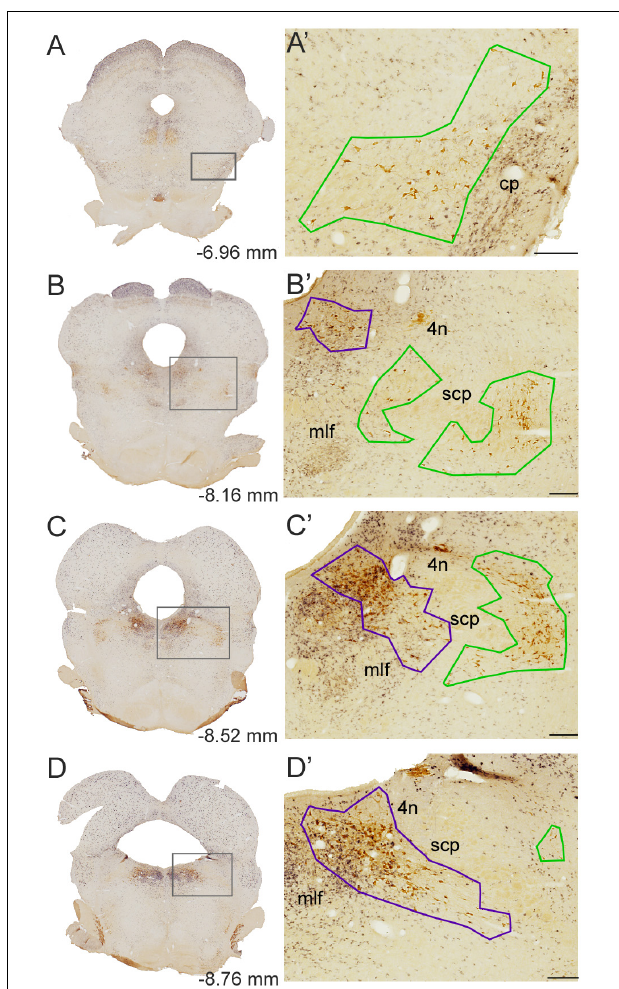
FIGURE 2 | Delineation of the PPN and LDT. (A–D) Representative dually labeled sections in rostrocaudal sequence containing the PPN and LDT. Boxed areas are shown at higher magnification in A’–D’ . (A’–D’) PPN (green) and LDT (purple) contours were drawn at 10 × , prior to quantification. Delineations were carried out linking with straight lines the outermost cholinergic neurons. The PPN included the medial extension ventral to the scp (SPTg in Paxinos and Watson’s atlas; B’,C’ ) whereas the LDT also included LDTV (C’,D’) . scp, superior cerebellar peduncle; mlf, medial longitudinal fasciculus; 4n, trochlear nucleus. Scale bars: 200 µ m. The scale bar in D corresponds to B’–D’ .